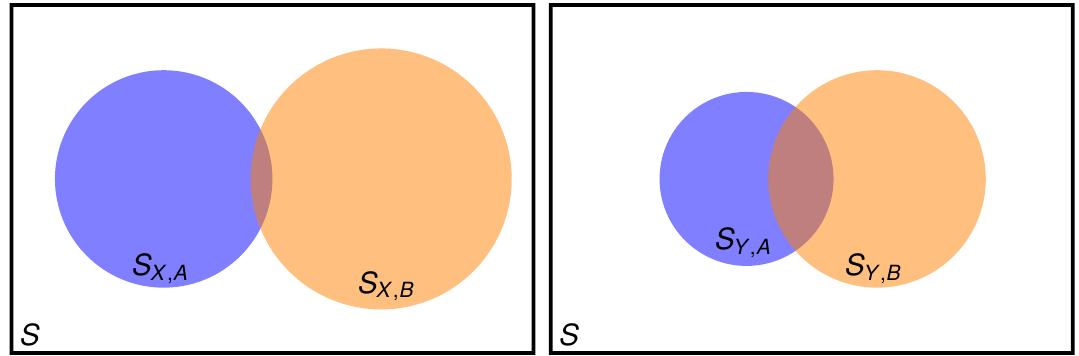
Figure 1. Diagrammatic explanation that method X can be better than method Y for property A and property B when taken separately, but method Y is better when both A and B are needed. Blue disks: cases when the method works well for property A ; orange disks: cases when the method works well for property B ; ( left ) method X ; ( right ) method Y